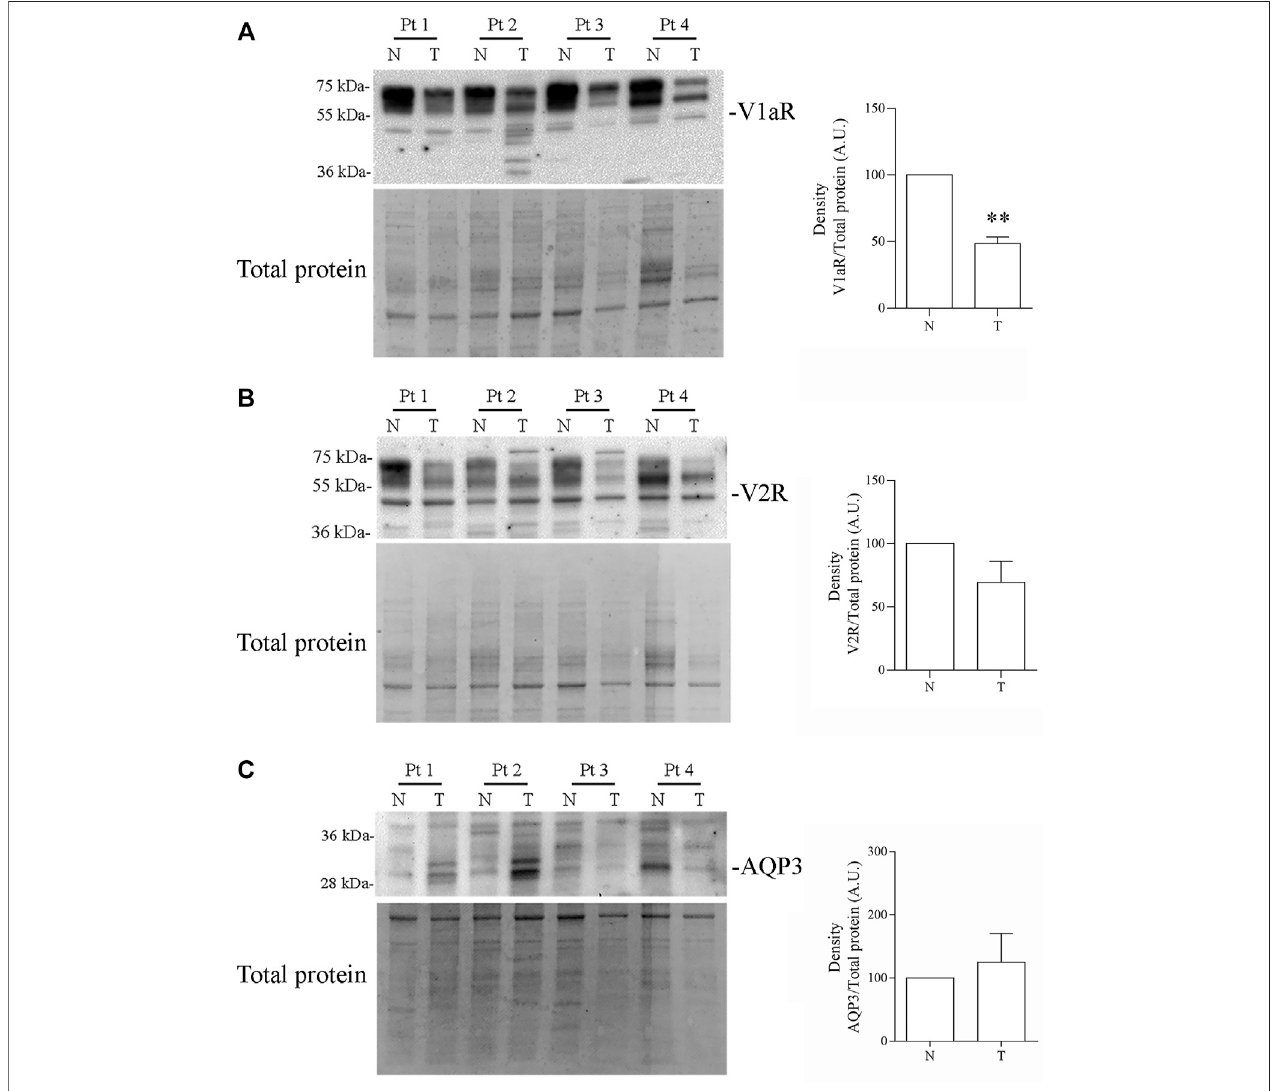
FIGURE 13 | Expression of Vasopressin receptors and AQP3 in human colon biopsy. Equal amount of proteins (20 µg) of total homogenates from human colon biopsies were blotted and probed with the indicated antibodies. (A) Immunodetection revealed that V1aR protein expression is signi fi cantly decreased in tumors compared to the normal colon mucosa. (B – C) Immunodetection revealed that V2R and AQP3 protein expression is not altered in human colon adenocarcinoma. Data are shown as mean ± S.E.M. and analyzed by Student ’ s t -test (** p < 0.01 vs. normal colon mucosa).